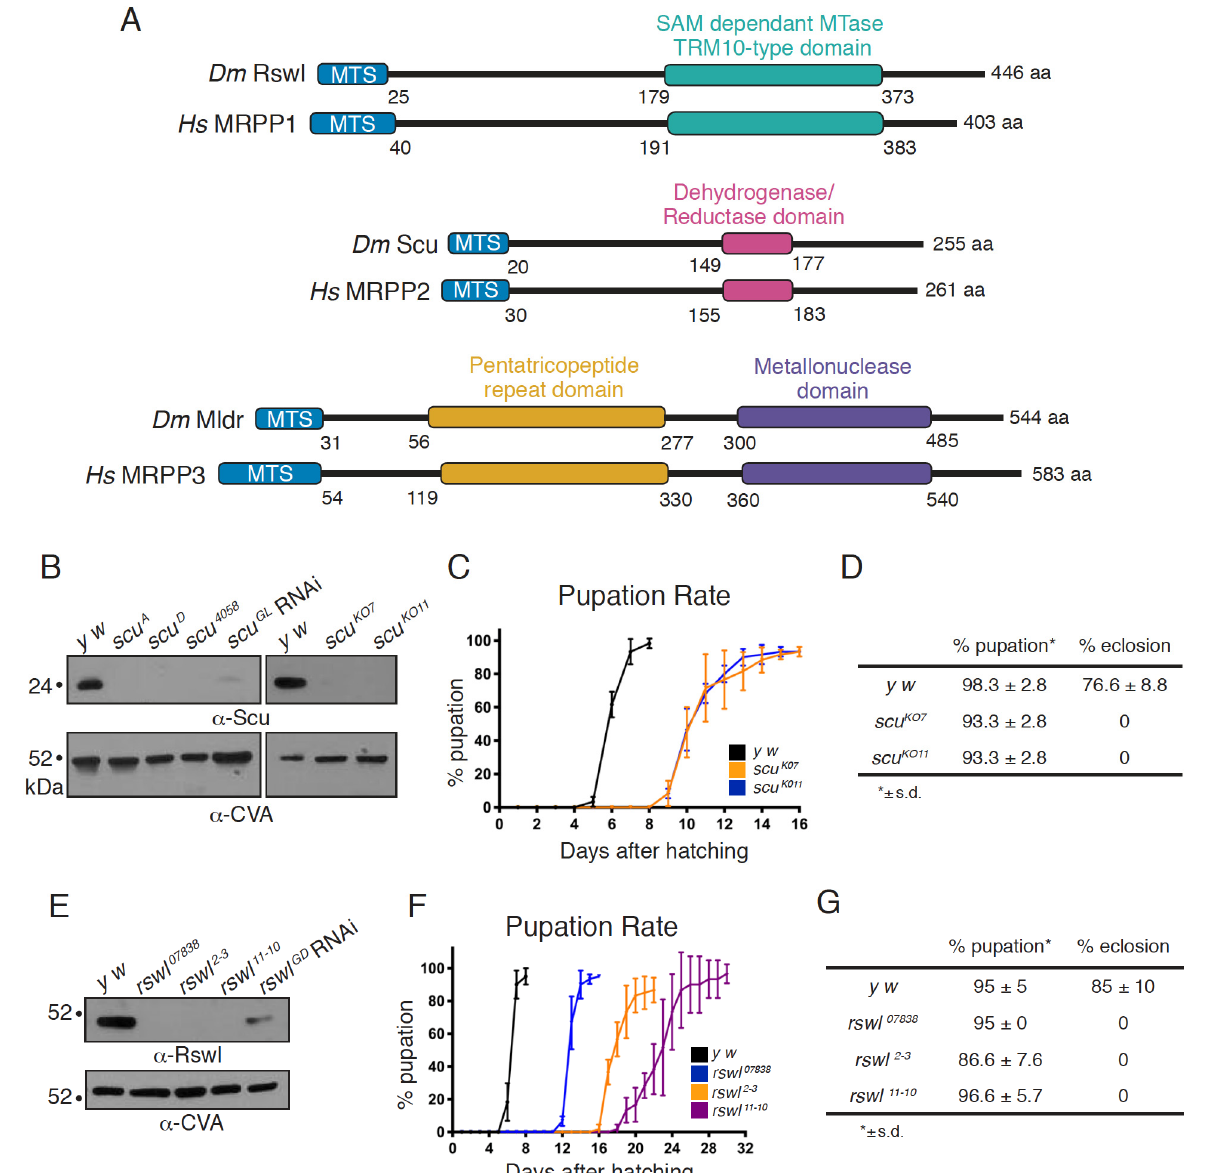
Figure 1. Loss of function alleles of rswl and scu cause lethality in flies. ( A ) Schematic showing the domain structure of Roswell, Scully, and Mulder and their homology in humans. The mitochondrial targeting sequence (MTS, blue) was predicted using MitoProt server, and the domain boundaries were predicted using Clustal Omega based on human homologs [30,31]. MTase: methyltransferase. ( B – D ) CRISPR/Cas9 induced loss of scu caused lethality. ( B ) Antibodies raised against Scu indicate all five scu alleles appear protein null via Western blot compared to the wild-type ( y w ), including ubiquitous scu GL RNAi expression. ( C , D ) scu KO7 and scu KO11 had delayed pupation ( C ) and failed to eclose ( D ) at room temperature. ( E – G ) The three rswl alleles did not have detectable protein on Western blot. Ubiquitous rswl GD RNAi expression shows reduced protein levels ( E ). ( F ) rswl mutant larvae eventually pupate but had delayed development, and none enclosed at room temperature ( G ). CVA: anti-ATP synthase. s.d. was calculated using GraphPad PRISM ( C , D , F , G ).